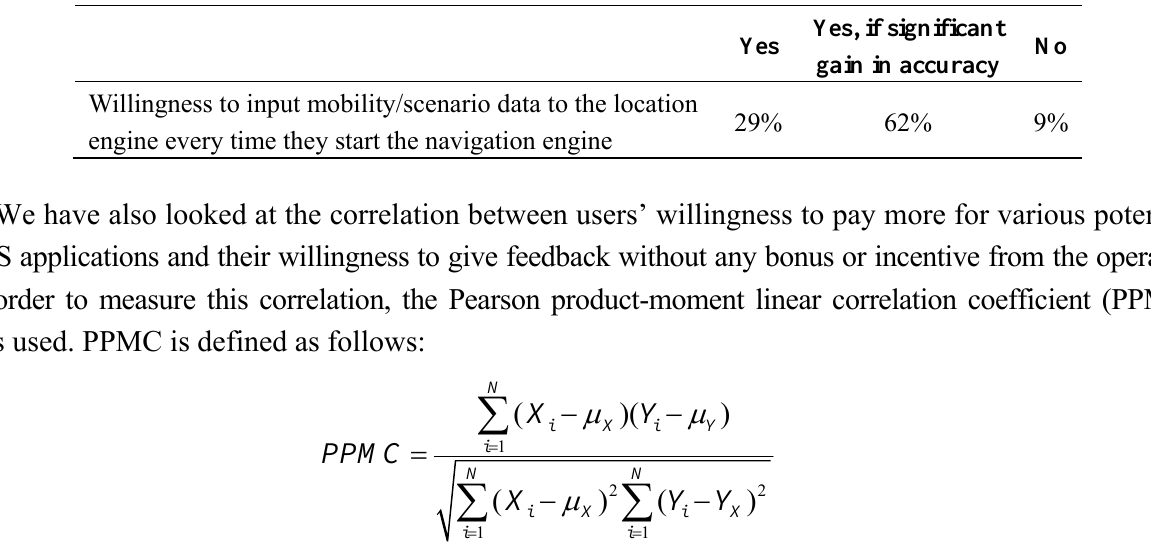
Table 2. Willingness to give input when starting the